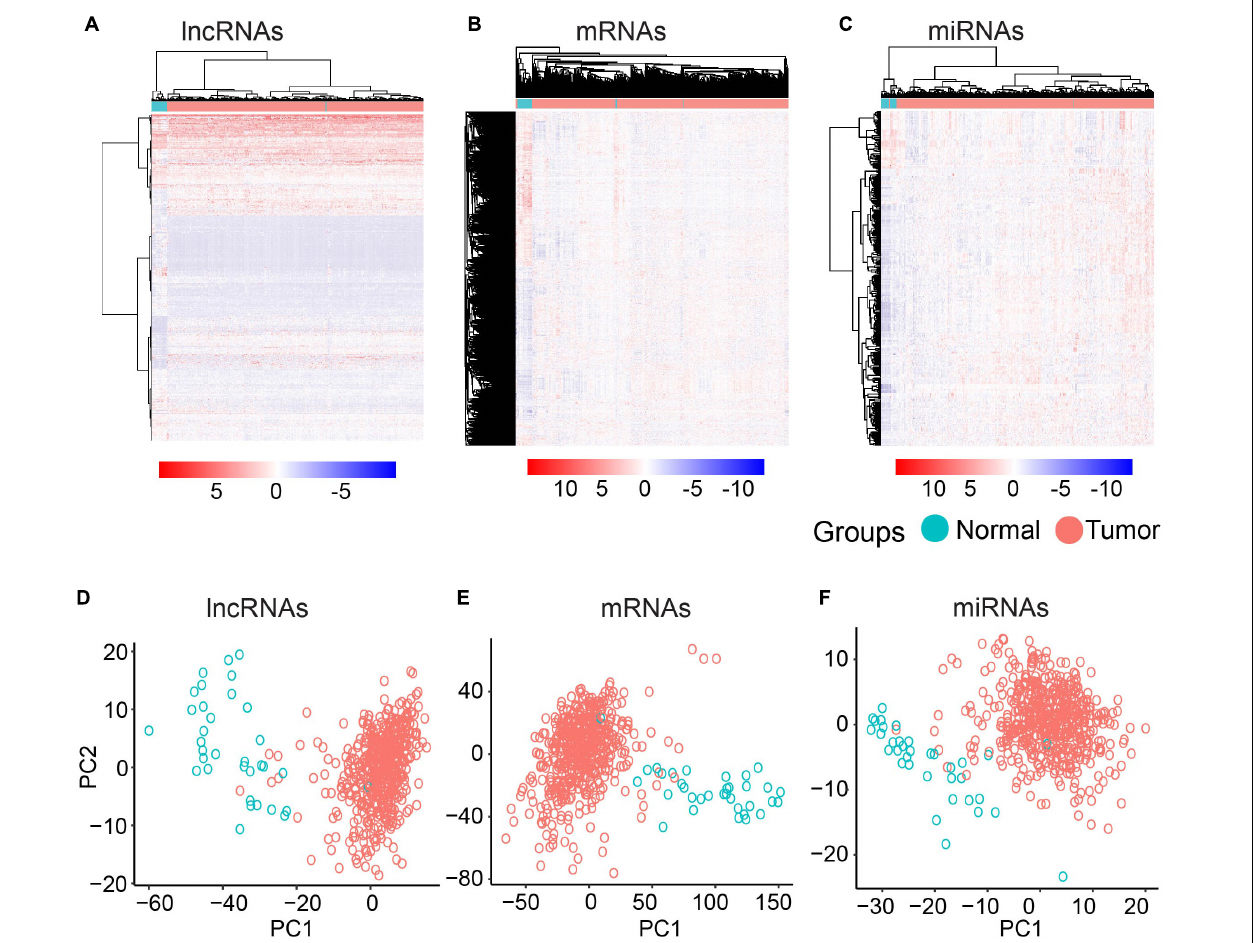
FIGURE 1 | Clustering based on differentially expressed molecules. Heatmap of clustering for UCEC and the normal samples based on differentially expressed lncRNAs (A) mRNAs (B) and miRNAs (C) . PCA analysis for differentially expressed lncRNAs (D) mRNAs (E) and miRNAs (F) .